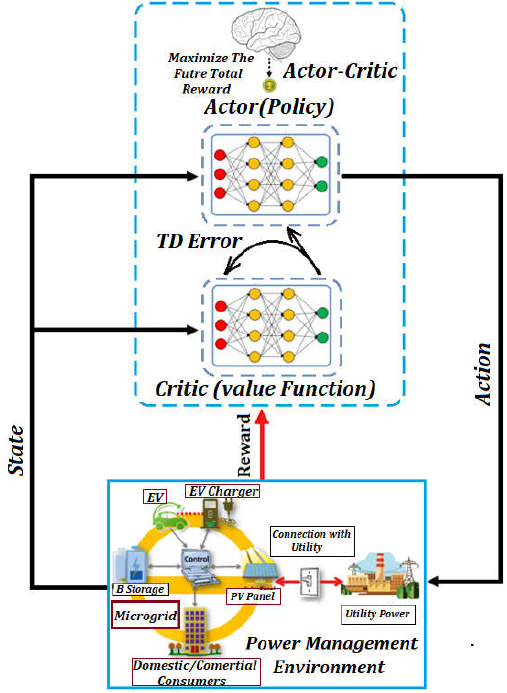
Figure 6. Actor–critic RL policy.